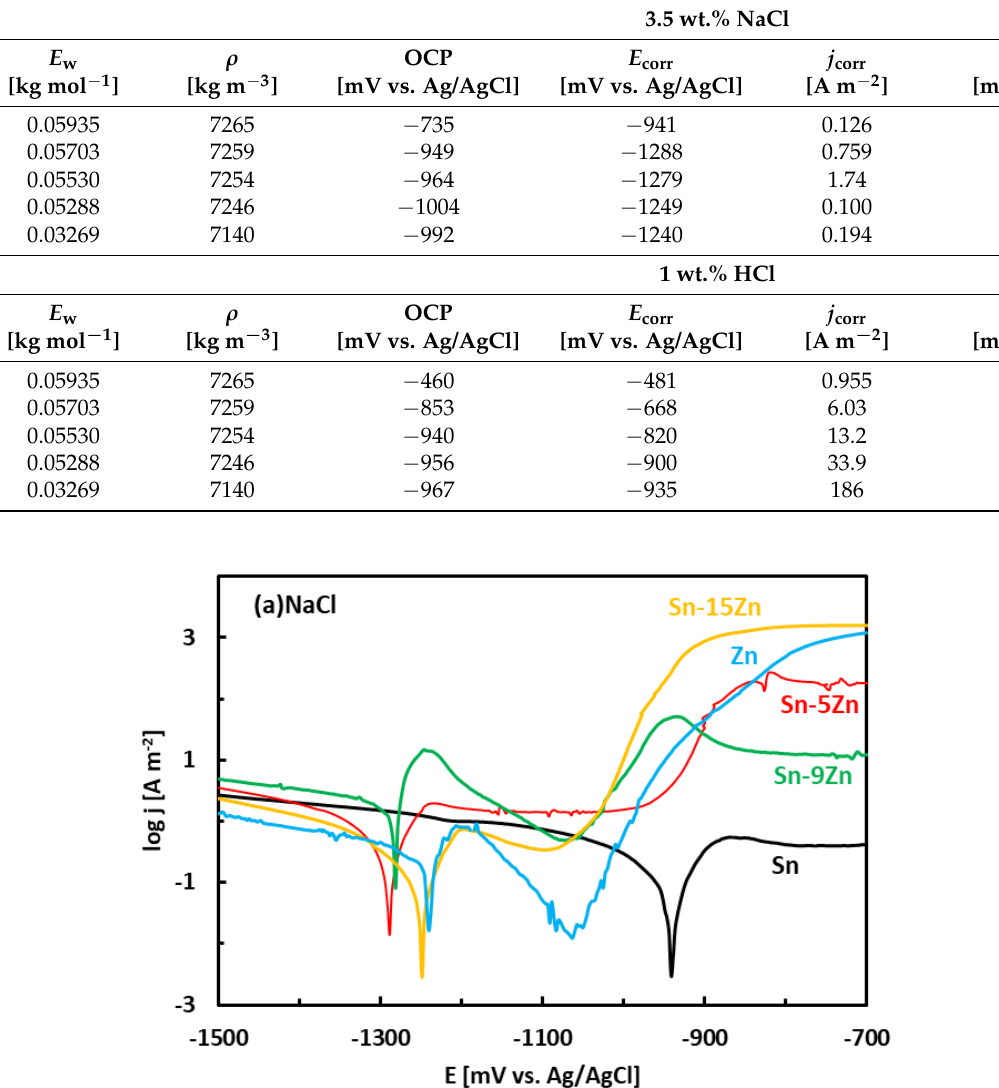
Table 2. Physicochemical properties and experimental corrosion parameters of the Sn–xZn alloys studied in this work.